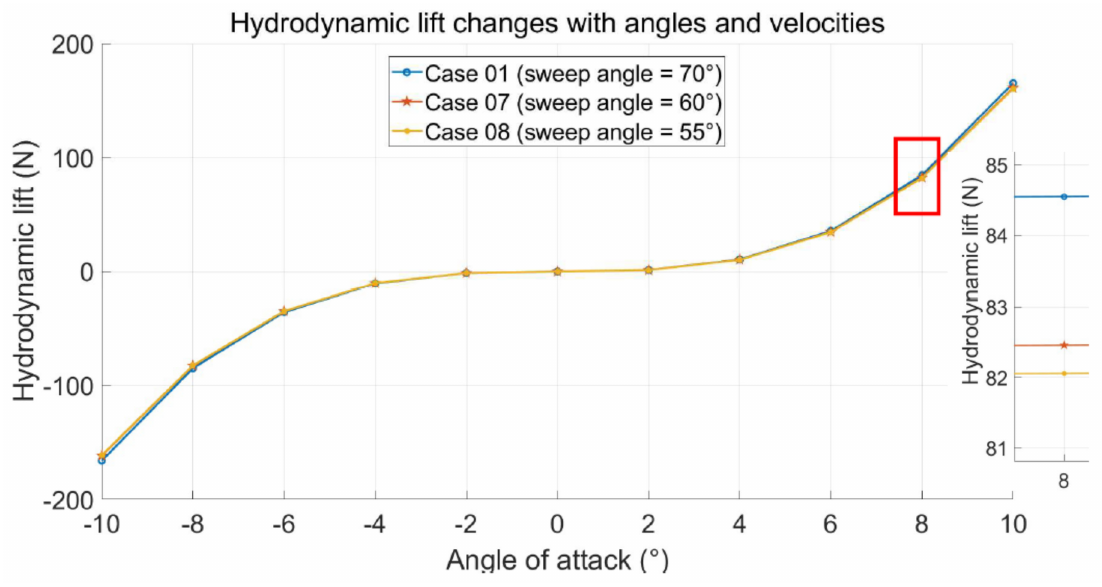
Figure 9. Variation in the hydrodynamic moment with angles and velocities.